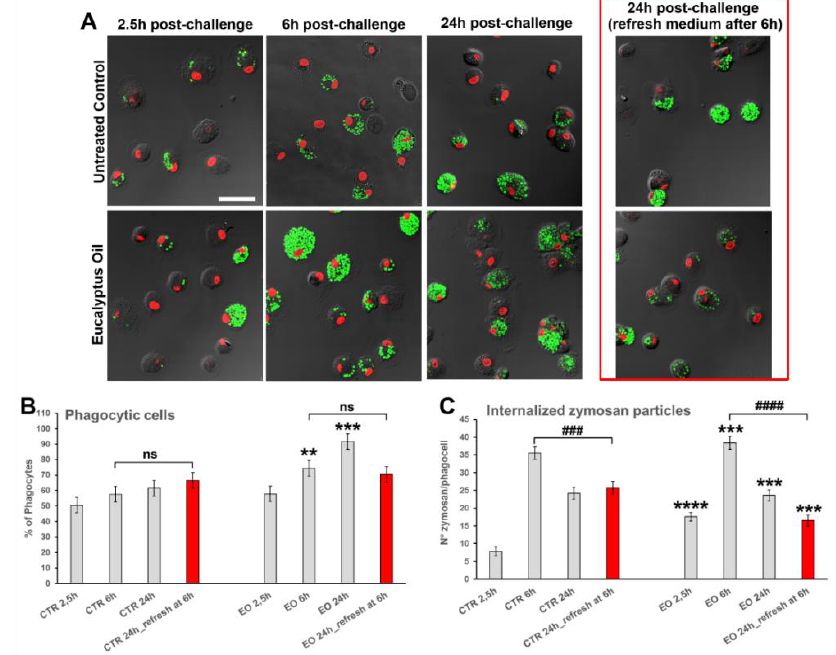
Figure 3. Effects of Eucalyptus oil treatment on phagocytic activity and clearance of zymosan ( S. cerevisiae ) particles by human MDMs. The phagocytic activity of MDMs pre-treated for 24 h with 0.008% EO and of untreated controls was tested by adding to cultures Alexa Fluor 488-labeled zymosan (green hue) in a ratio of 20 particles/cell, as described in Materials and Methods. Samples were analyzed 2.5 h, 6 h, and 24 h after zymosan particle administration. To evaluate the ability of MDMs to eliminate the yeast, in a parallel experiment, 6 h post-challenge the medium was replaced with fresh zymosan-free medium, and cells were analyzed after additional 18 h. ( A ) Confocal